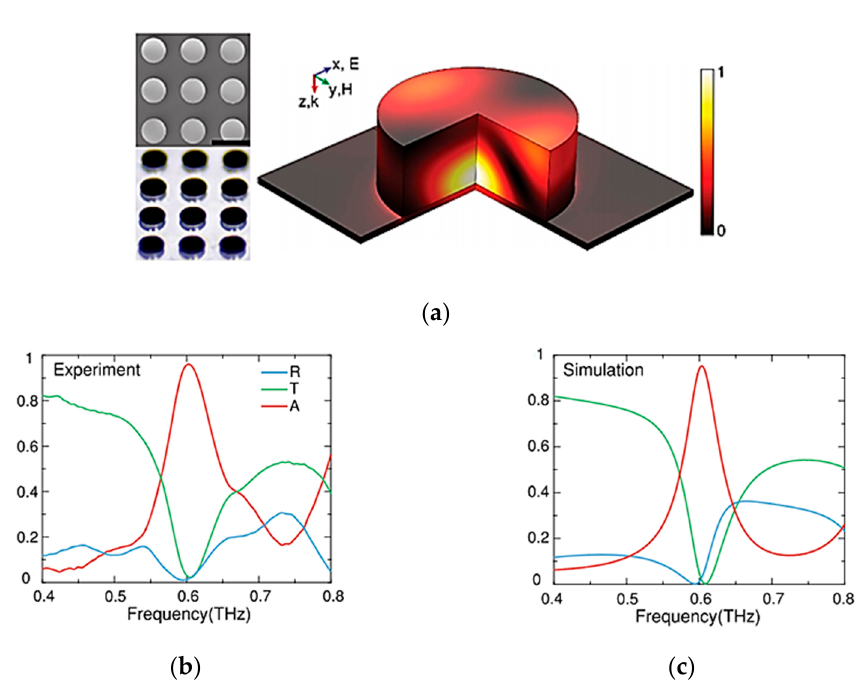
Figure 8. ( a ) Scanning electron microscopic image of fabricated cylinder array; ( b ) measured reflectance R (blue), transmittance T (green), and absorbance A (red) of the dielectric absorber; ( c ) numerically simulated R, T, and A [45].